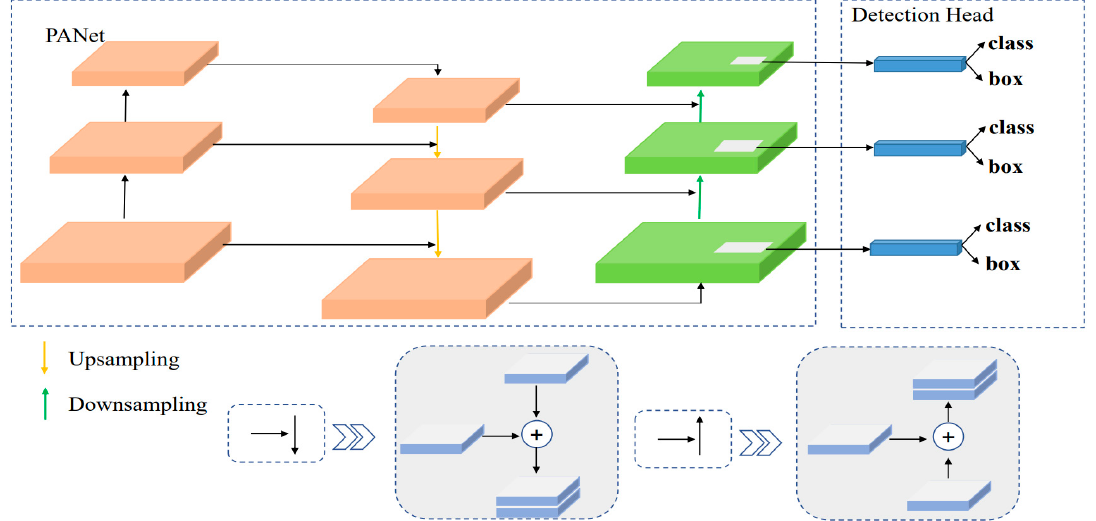
Figure 7. Multi-scale feature fusion and prediction were used to fuse location and semantic information at different scales .